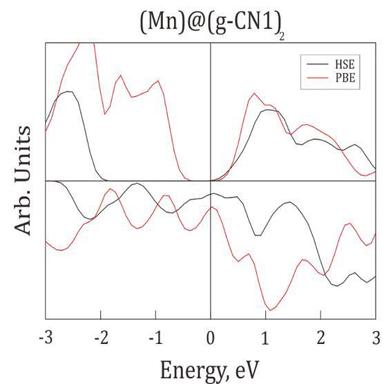
The total density of states of (Mn)@(g-CN1)2 was calculated at HSE (black solid line) and PBE (red solid line) levels of theory.